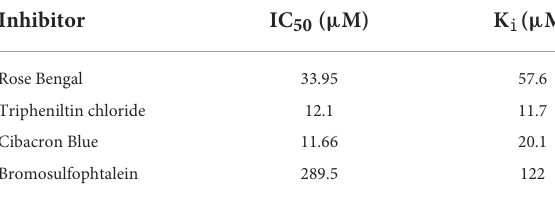
TABLE 2 Inhibition of SmGST by various classic glutathione transferase inhibitors.